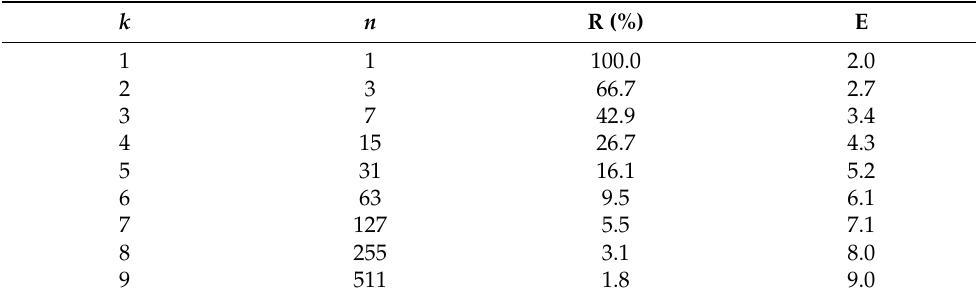
Table 11. Algorithm performance comparison table.